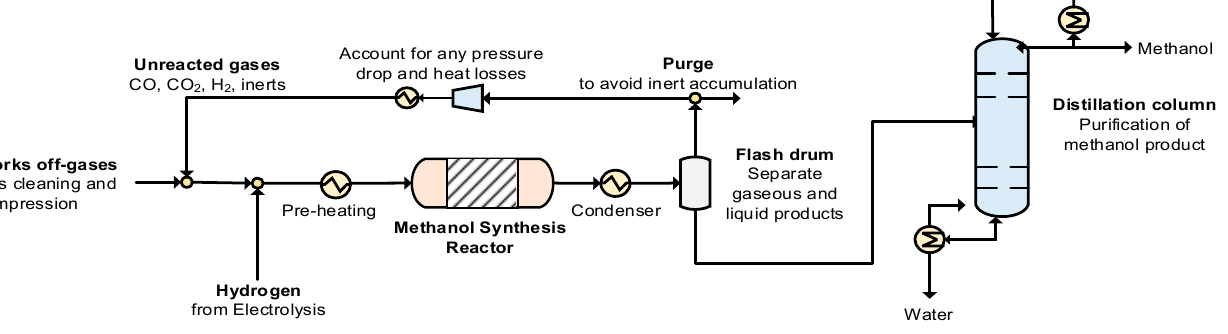
Figure 8. Methanol synthesis process flowsheet.